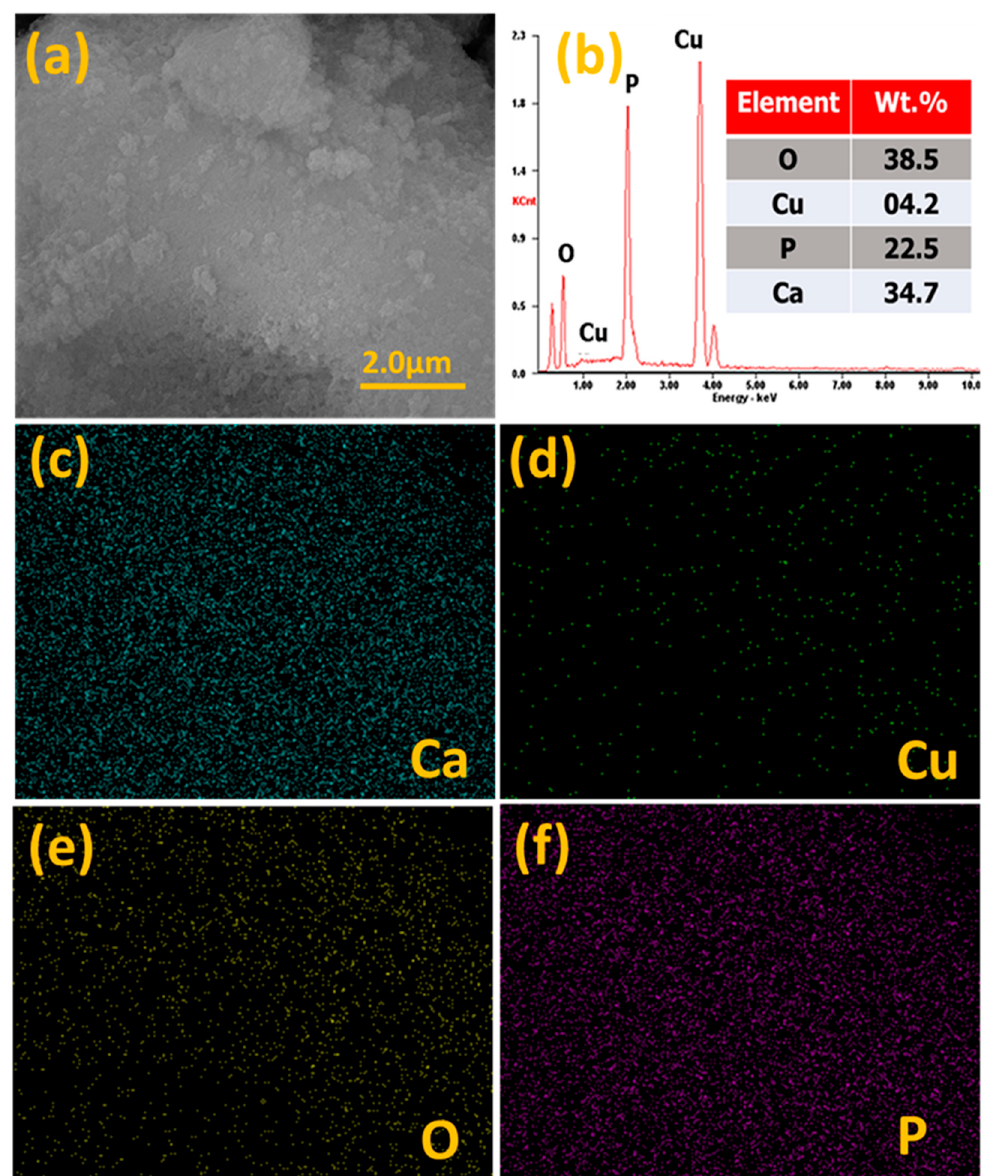
Figure 6. ( a ) SEM image, ( b ) EDS results and ( c – f ) are corresponding EDS elemental mapping images of 5CuHAp catalyst.